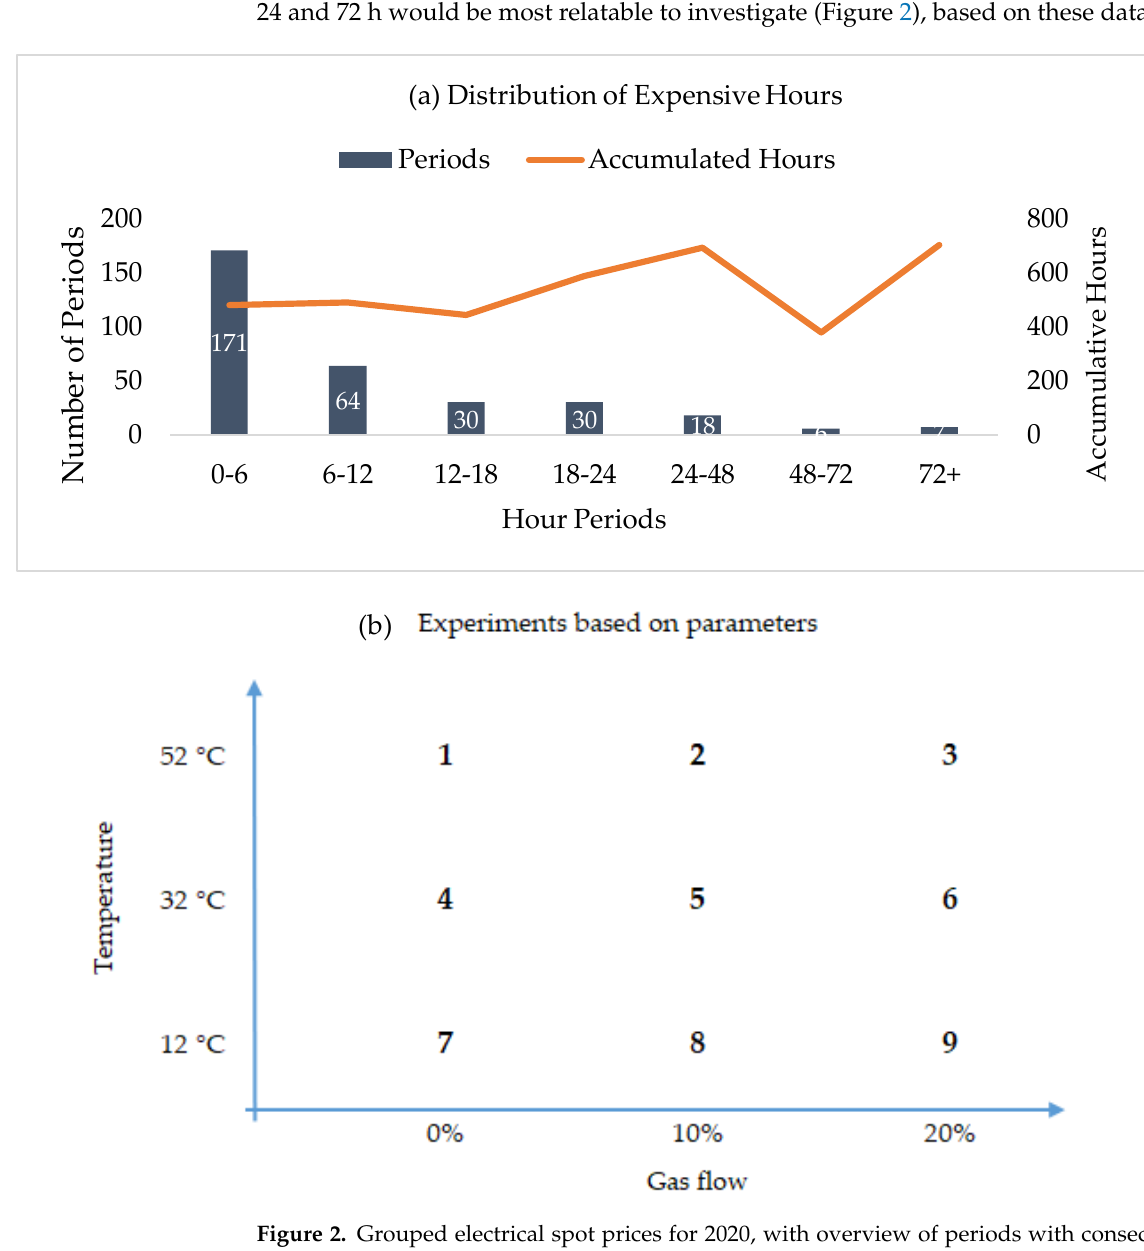
Figure 2. Grouped electrical spot prices for 2020, with overview of periods with consecutive too high electrical price, compared to preset limit, to find downtime lengths that needs investigation. ( a ) Grouping of electrical spot prices. Blocks indicate the number of periods with that number of periods within that grouping. Line indicates the accumulative number of hours from the number of periods in that hour range. ( b ) Experimental overview for each length of downtime. The influence of temperature and gas flow gave 9 combinations for each downtime